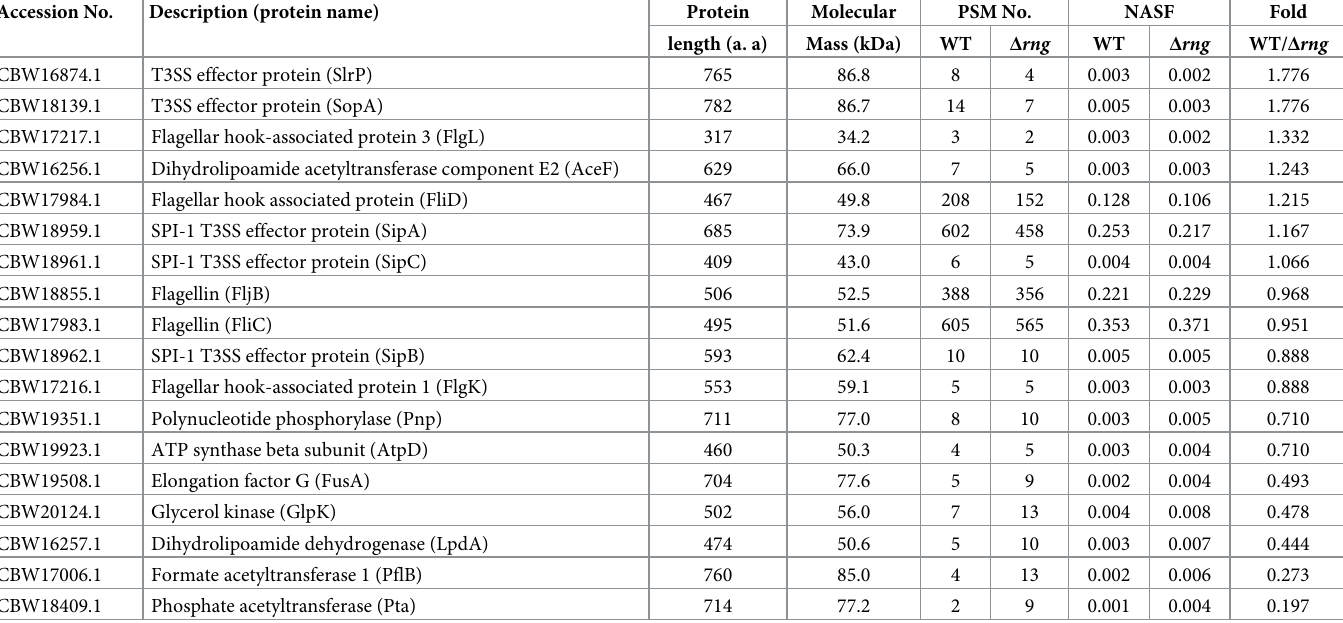
Table 1. Normalized spectral abundance factors and fold changes in proteins identified by tandem mass spectrometry analysis of in-gel digested bands from the supernatants of WT and Δ rng Salmonella Typhimurium. Accession